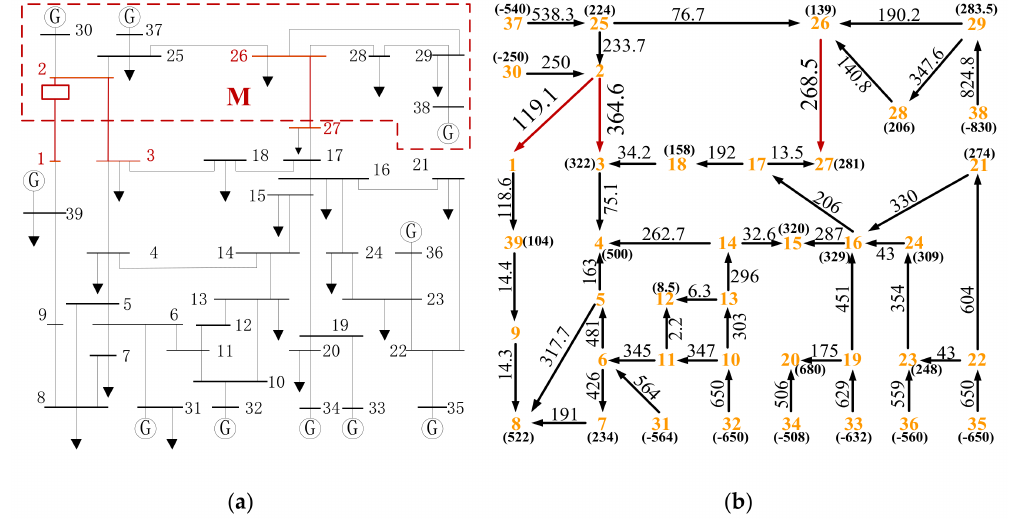
Figure 12. The IEEE 39 bus system without any power flow control devices. ( a ) The IEEE 39 bus system; ( b ) The active power flow